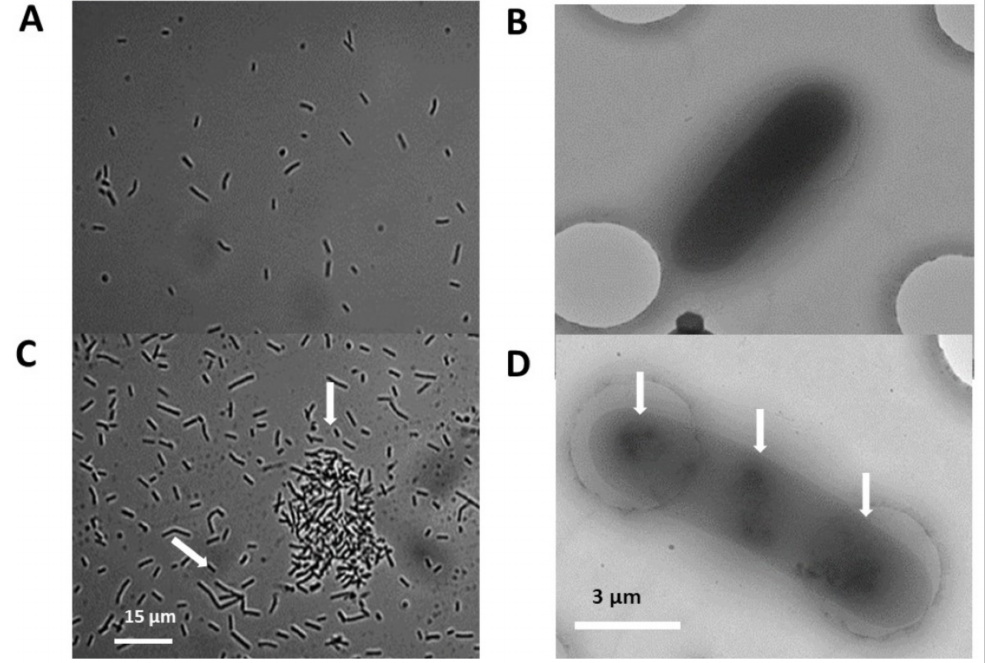
Figure 3. Micrographs of bacterial cells grown with and without silica nanoparticles (SN): Typical light- and cryo-electron microscopic images of A26 and A26Sfp cells ( A , B ), and A26SN and A26SfpSN cells ( C , D ). Arrows indicate cell elongation, bacterial aggregate formation, and changes in nucleoid structure. See Section